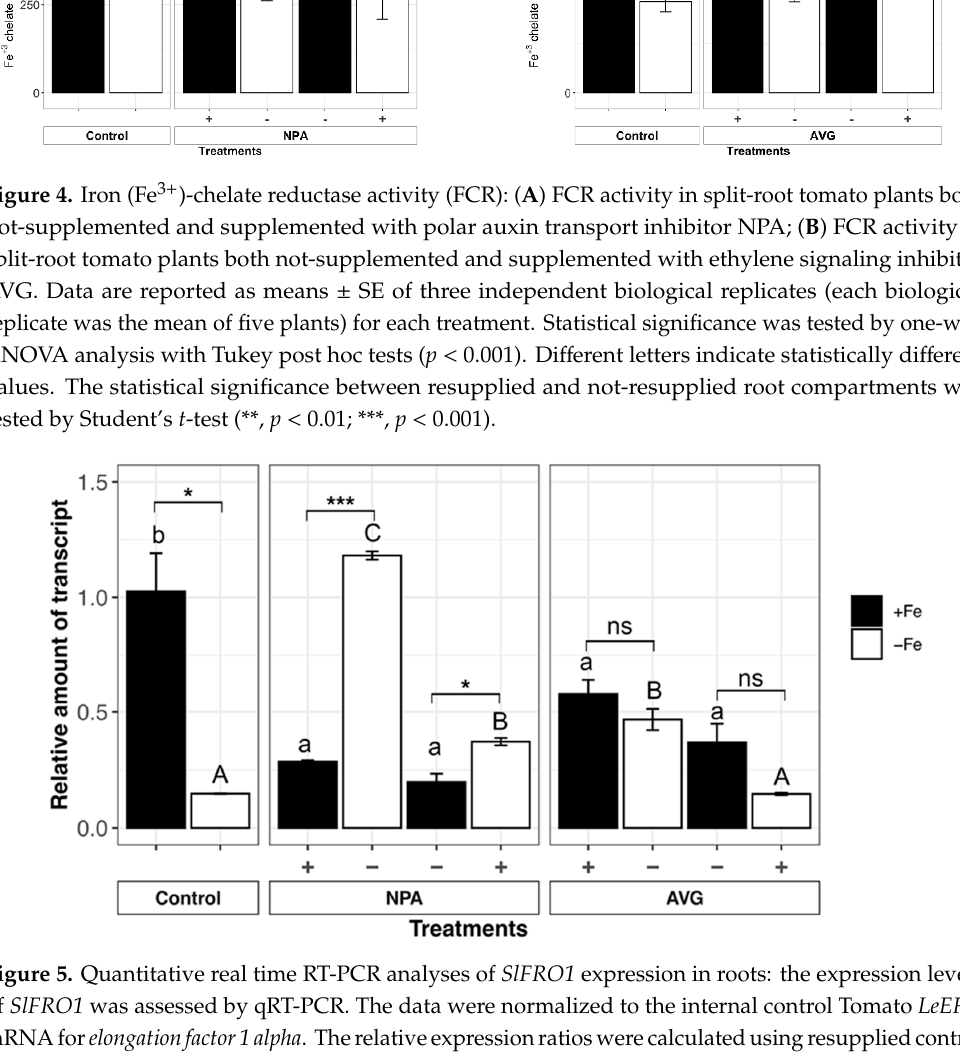
Figure 4. Iron (Fe 3+ )-chelate reductase activity (FCR): ( A ) FCR activity in split-root tomato plants both not-supplemented and supplemented with polar auxin transport inhibitor NPA; ( B ) FCR activity in split-root tomato plants both not-supplemented and supplemented with ethylene signaling inhibitor AVG. Data are reported as means ± SE of three independent biological replicates (each biological replicate was the mean of five plants) for each treatment. Statistical significance was tested by one- way ANOVA analysis with Tukey post hoc tests ( p < 0.001). Different letters indicate statistically different values. The statistical significance between resupplied and not-resupplied root compartments was tested by Student’s t -test (**, p < 0.01; ***, p < 0.001).